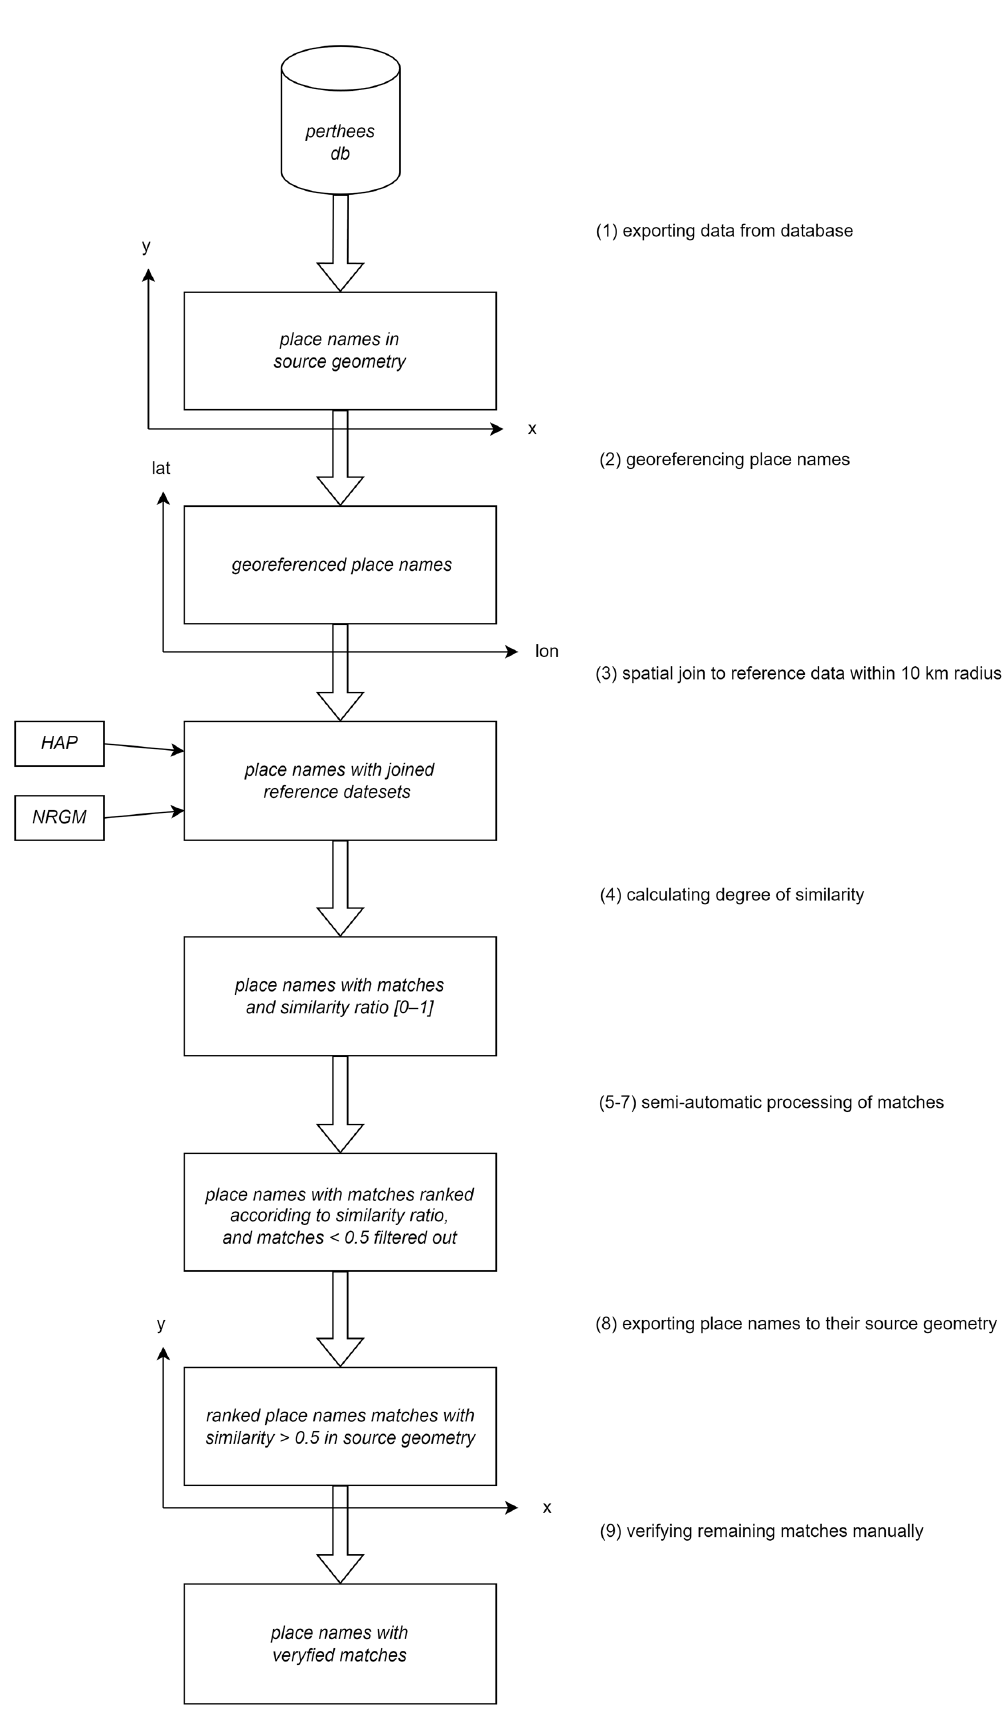
Figure 4. The outline of the proposed approach of geocoding place names from inaccurate historic